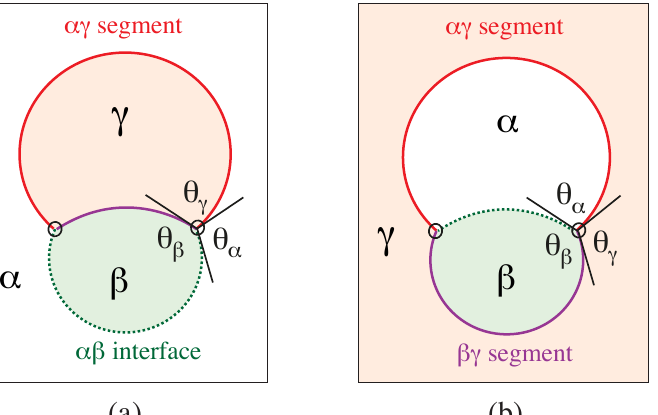
Figure 8. Apparent contact angles θ α , θ β , and θ γ for the vesicle-droplet systems in Figure 1: Phase separation of ( a ) exterior solution and ( b ) interior solution into the two liquid phases α and β . The contact angle θ α is the angle between the αβ interface (broken green line) and the αγ membrane segment (red line); the angle θ β is the angle between the αβ interface and the βγ membrane segment (purple line); and θ γ is the angle between the αγ and βγ membrane segments. The two contact lines, at which the three surface segments meet, are indicated by the four open circles in panel a and b.